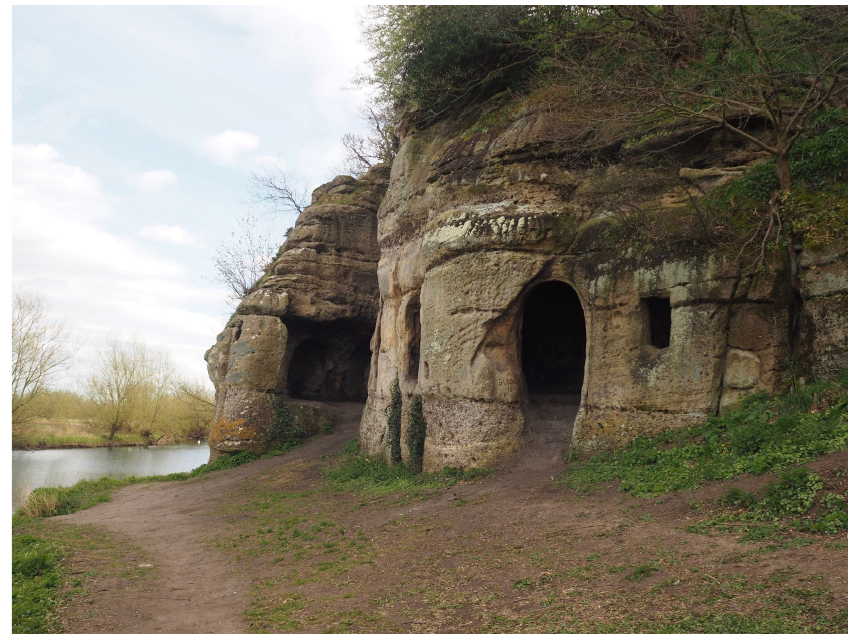
Figure 2. Anchor Church, Derbyshire, is a probable early medieval hermitage adapted and used in the eighteenth and nineteenth centuries, but with little change to the fabric. Photograph E.R Simons.